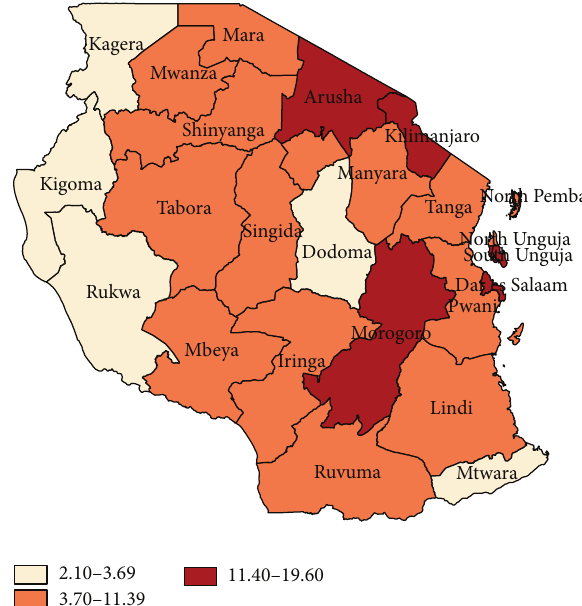
Figure 3: Obesity prevalence categories by region of residence among nonpregnant women of reproductive